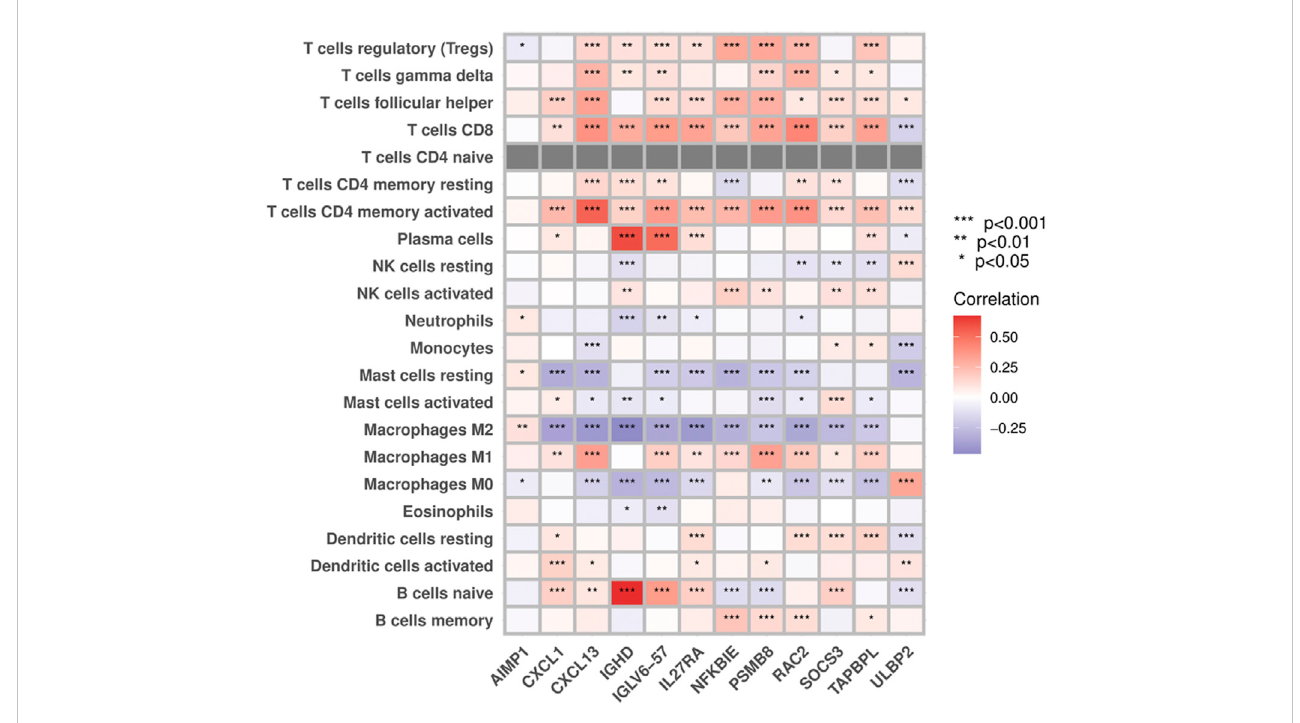
FIGURE 8 Correlations between prognostic immune-related genes and immune in fi